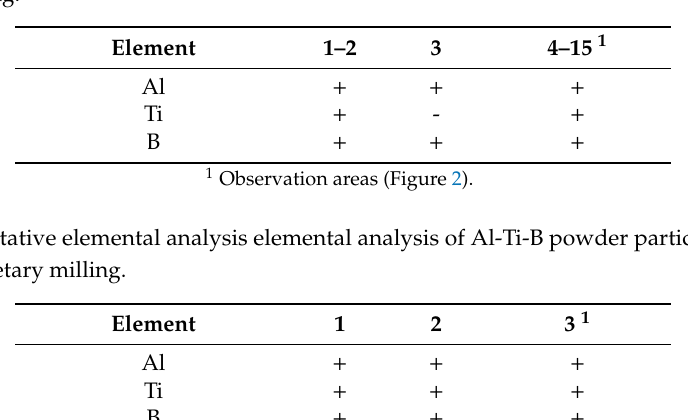
Table 3. Quantitative elemental analysis elemental analysis of Al-Ti-B powder particles after 900 s planetary milling.